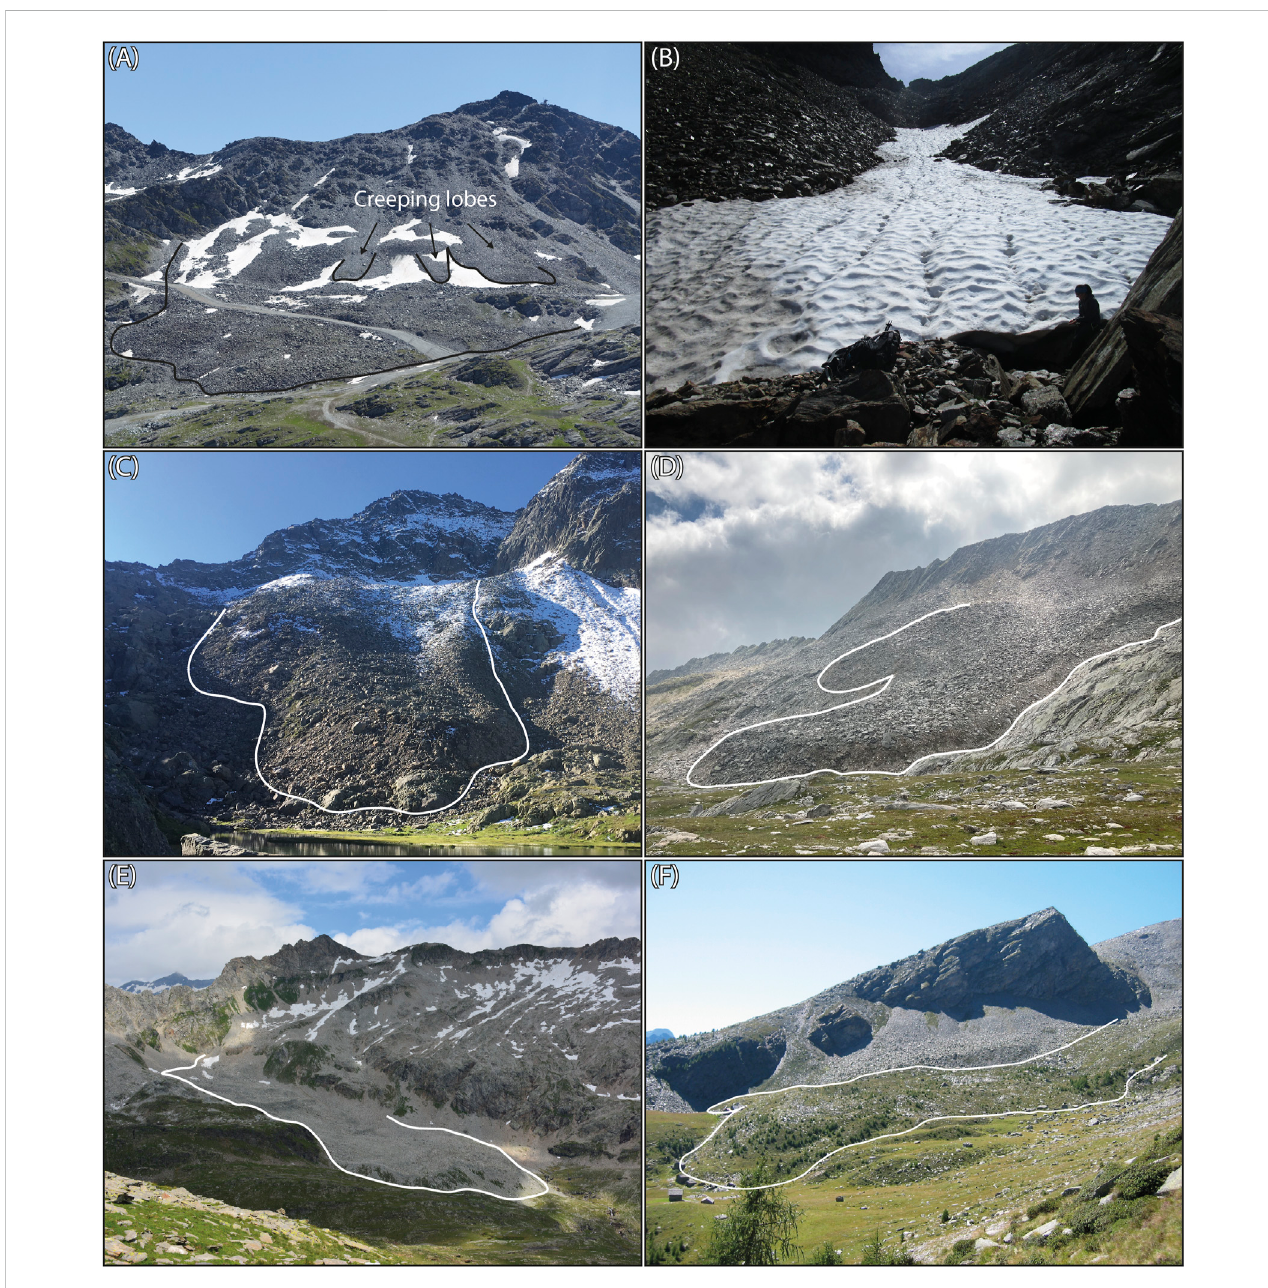
FIGURE 2 The rock glaciers and ice-patches investigated in this study: (A) Lac des Vaux active rock glacier, (B) Lago Nero ice patches, (C) Lago di Leìt active rock glacier, (D) GanonidiSchenadüiactiverockglacier, (E) AlpePièiinactiverockglacierand (F) AlpediSceruIrelictrockglacier. Photo (A) :C.Lambiel,photos (C) and (D) : C. Del Siro, photos (B) , (E) and (F) : C.